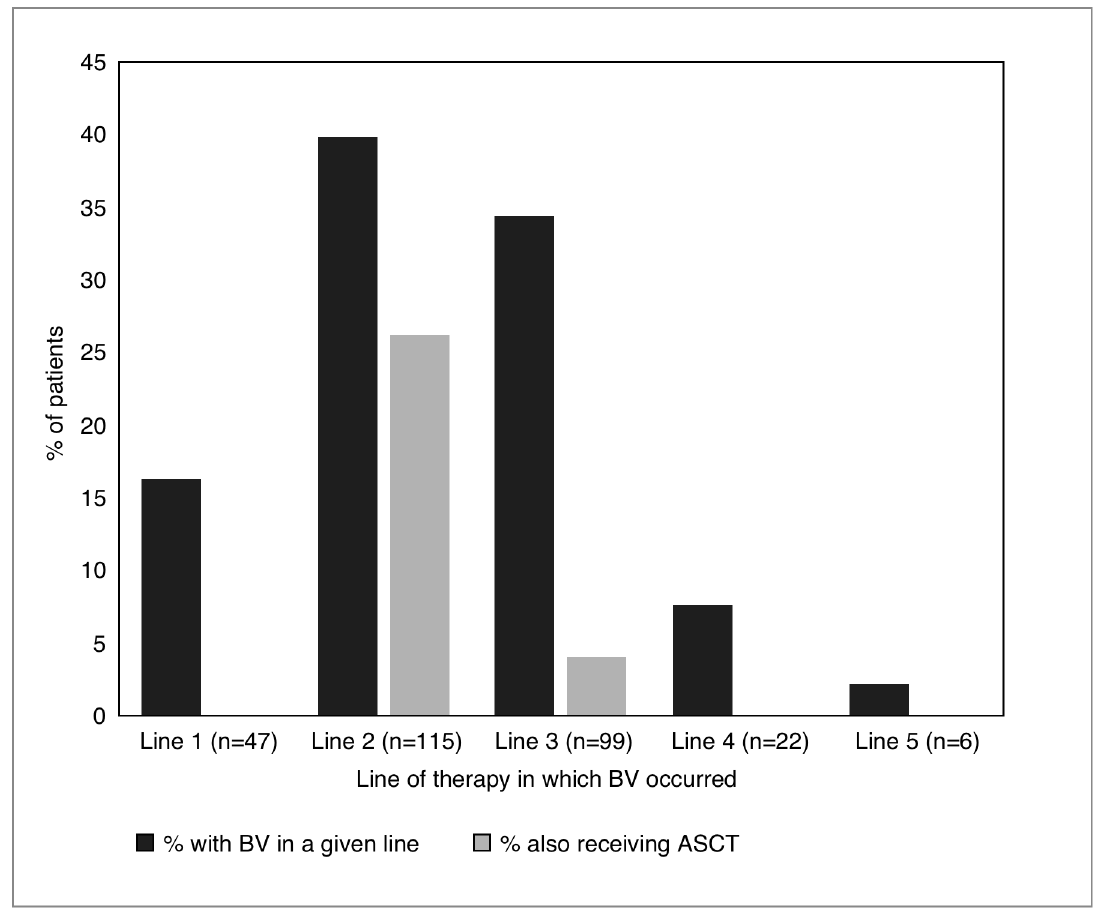
Fig 1. Timing of treatment with BV, and co-occurrence with ASCT, within observed lines of therapy.